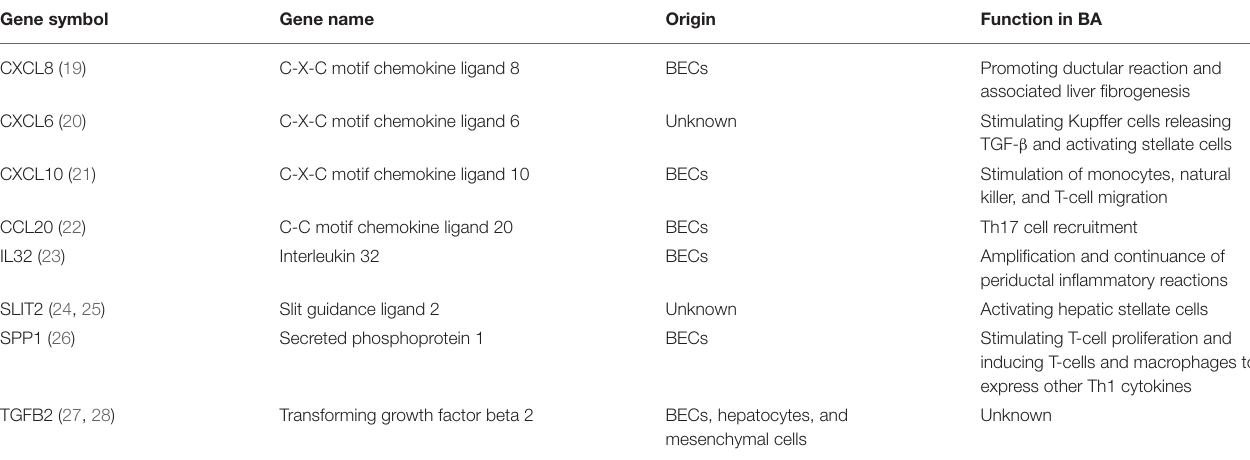
TABLE 1 | List of eight immune-related differentially expressed genes in biliary atresia (BA) and their functions in the progress of BA. Gene